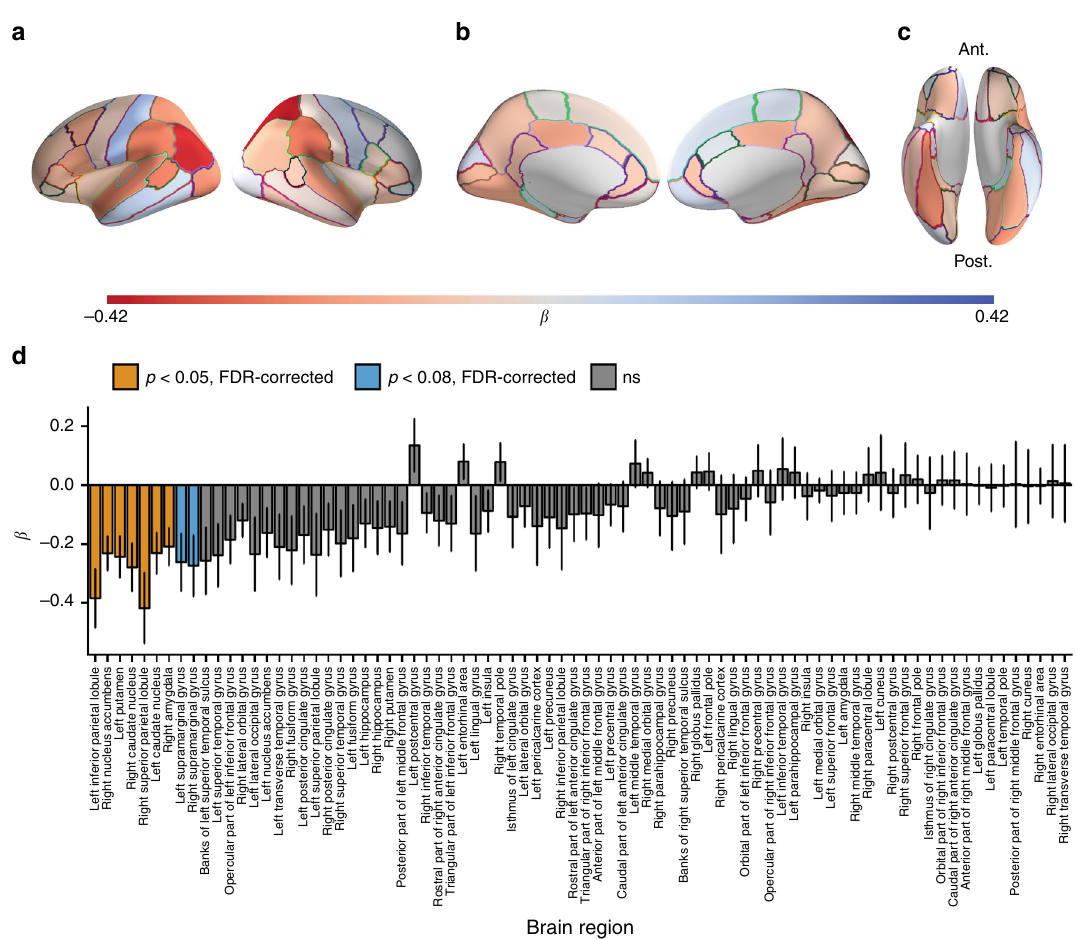
Fig. 6 Testing associations between neural response similarity and social distance by brain region. As described in the main text, ordered logistic regression analyses were carried out for each brain region in which social network distances were modeled as a function of local neural response similarities and dyadic dissimilarities in control variables (gender, ethnicity, nationality, age, and handedness). Negative regression coef fi cients for neural response similarity indicate that greater neural response similarity was associated with decreased social distance. Regression coef fi cients for the effects of neural response similarity on social distance for each cortical ROI are shown overlaid on a lateral, b medial, and c ventral views of the cortical surface. Ant. = anterior; Post. = posterior. In each view, the left hemisphere is displayed on the left. Cortical surface visualizations were created using PySurfer 58 . Warmer colors indicate negative regression coef fi cients (i.e., where greater neural response similarity was associated with social network proximity), whereas cooler colors indicate positive regression coef fi cients (i.e., where greater neural response similarity was associated with increased social distance). d Regions where neural similarity was signi fi cantly predictive of social distance, above and beyond the effects of control variables ( p < 0.05, FDR-corrected, two-tailed) are shown in yellow, with marginally signi fi cant regions ( p < 0.08) shown in blue, and all other regions shown in gray. Error bars indicate